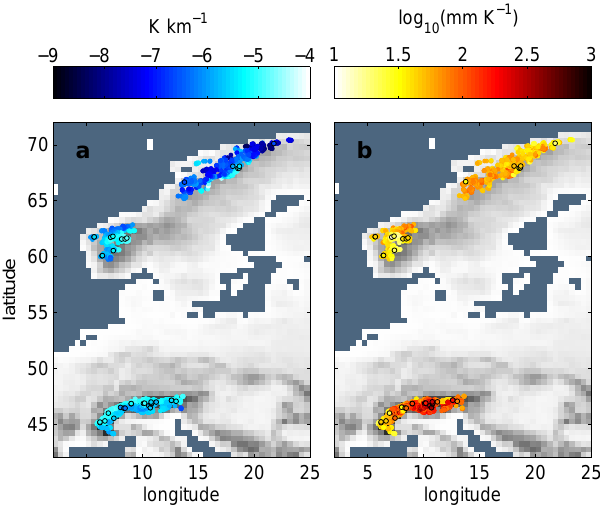
Fig. 2. Maps of the model parameters of the climatologically de- rived model: (a) temperature lapse rates. Values where the corre- lation between temperature and elevation is below the 95% con- fidence interval have been omitted. (b) µ clim . Markers with black circle indicate the results of the glaciers with more than 12 existing measurements of annual mass balance. Gray background shading: topography of the CRU TS 3.0